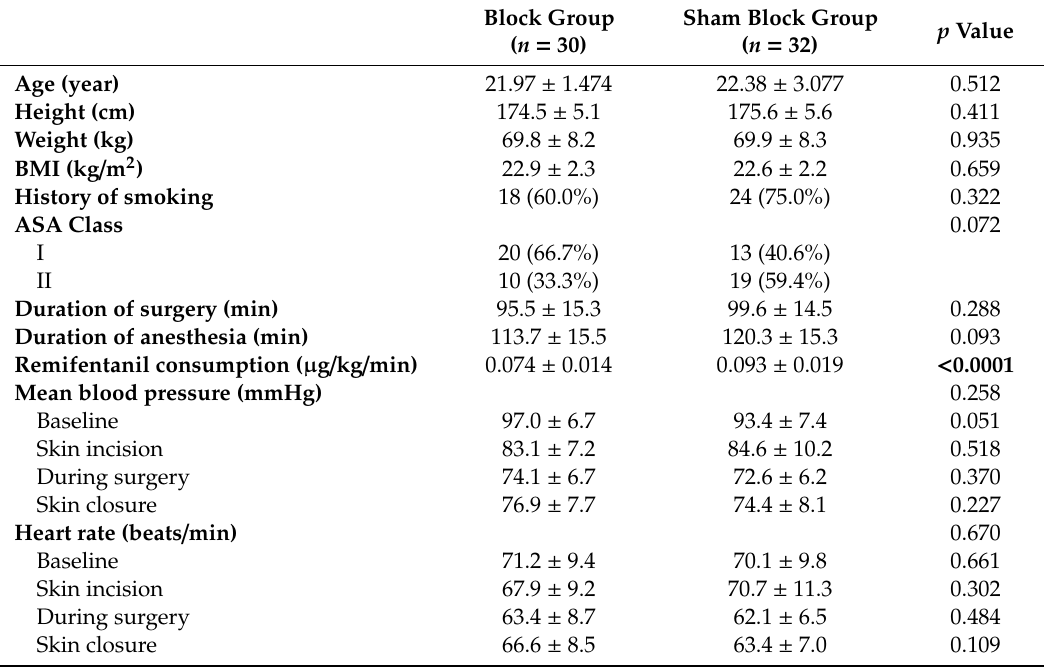
Figure 3. CONSORT flowchart of the study. Table 1. Preoperative and intraoperative characteristics. The data are presented as the mean ± standard deviation, median (IQR) and number (proportion; %). NRS, numerical rating scale; PACU, post-anesthesia care unit; PONV, postoperative nausea and vomiting.